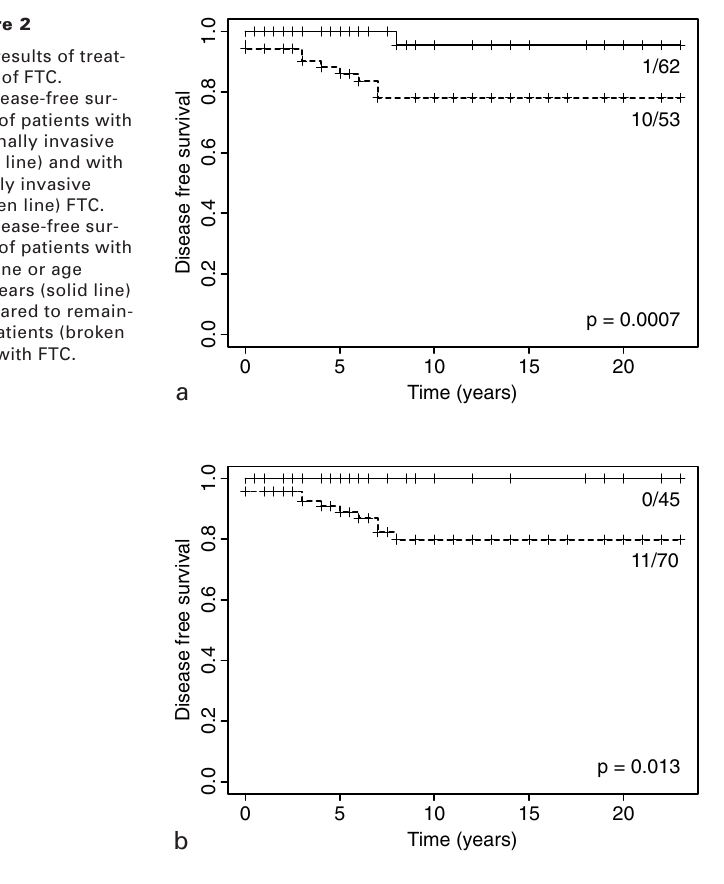
Figure 2 Late results of treat- ment of FTC. a. Disease-free sur- vival of patients with minimally invasive (solid line) and with grossly invasive (broken line) FTC. b. Disease-free sur- vival of patients with CI alone or age <45 years (solid line) compared to remain- ing patients (broken line) with FTC.